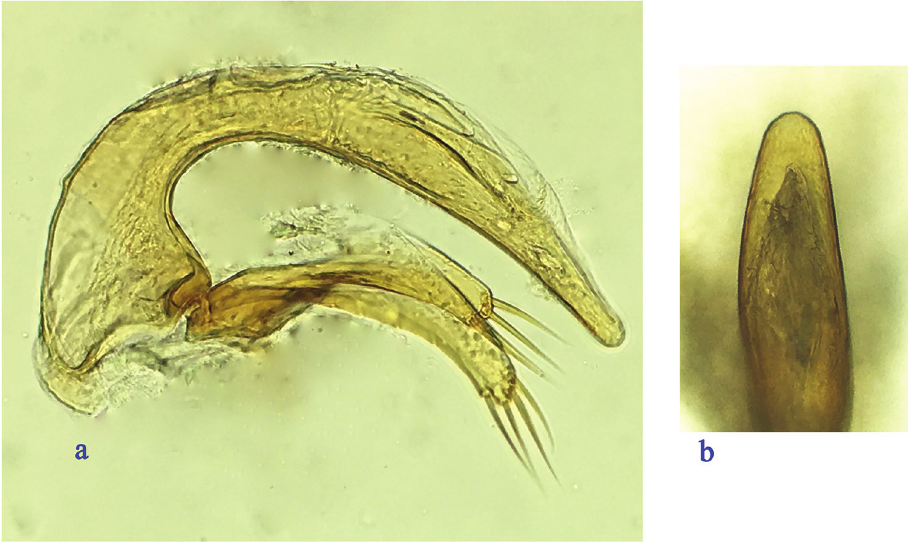
Figure 2. Male genitalia of Cimmeritodes ( Zhecimmerites ) parvus Tian & Li, sp. n., a median lobe and parameres, lateral view b apical lobe, dorsal